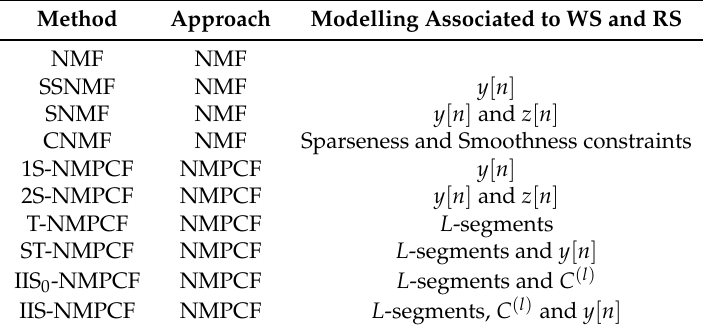
Table 3. Characteristics of the methods evaluated.